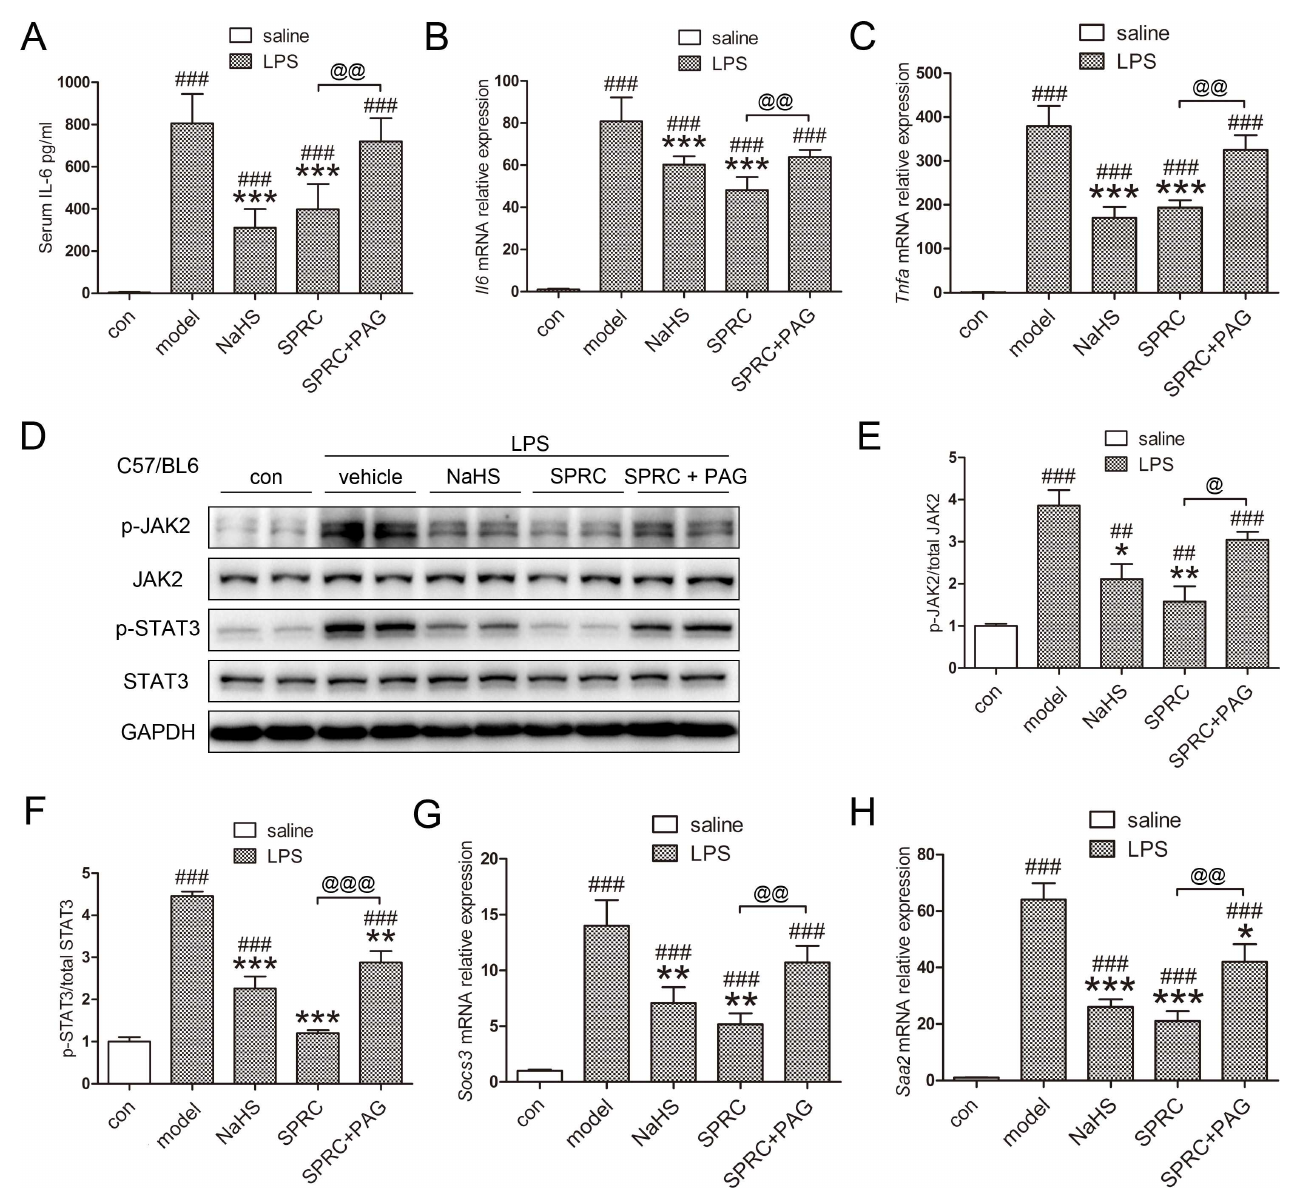
Fig 2. SPRC reduces inflammatory hepcidin activation by inhibiting IL-6/JAK2/STAT3 pathway. (A) SPRC and NaHS markedly decreased serum IL-6 levels induced by LPS (n = 5). (B-D) Hepatic Il-6 , Tnfa mRNA levels and JAK2/STAT3 phosphorylation were induced by LPS, and suppressed by SPRC and NaHS. Moreover, PAG diminishedthe effects of SPRC (n = 5). (E-F) Densitometry analysis of Fig 2D. (G-H) Hepatic mRNA levels of Socs3 and Saa2 , two target genes of STAT3 (n = 5). Representative immunoblots are presented. Whole uncropped images of Fig 2D are shown in S1 Fig. Data are presented as the mean ± SEM. ### p < 0.001 compared with the control group; * p < 0.05, ** p < 0.01, *** p < 0.001, comparedwith the LPS group; @ p < 0.05, @@ p < 0.01, @@@ p <